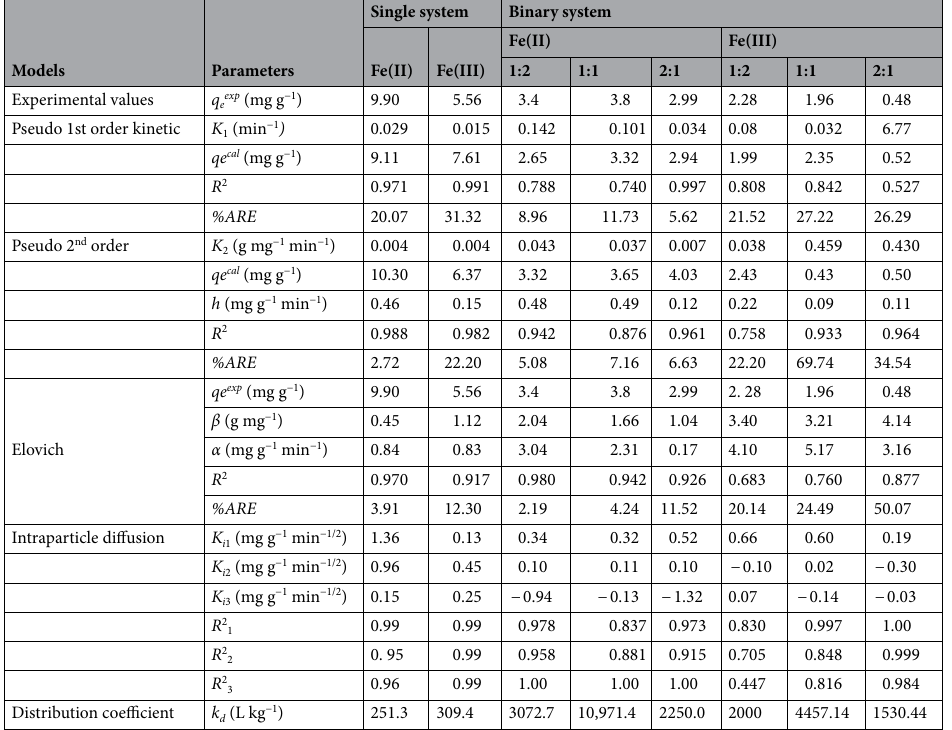
Table 3. Kinetic parameters for the adsorption of Fe(II) and